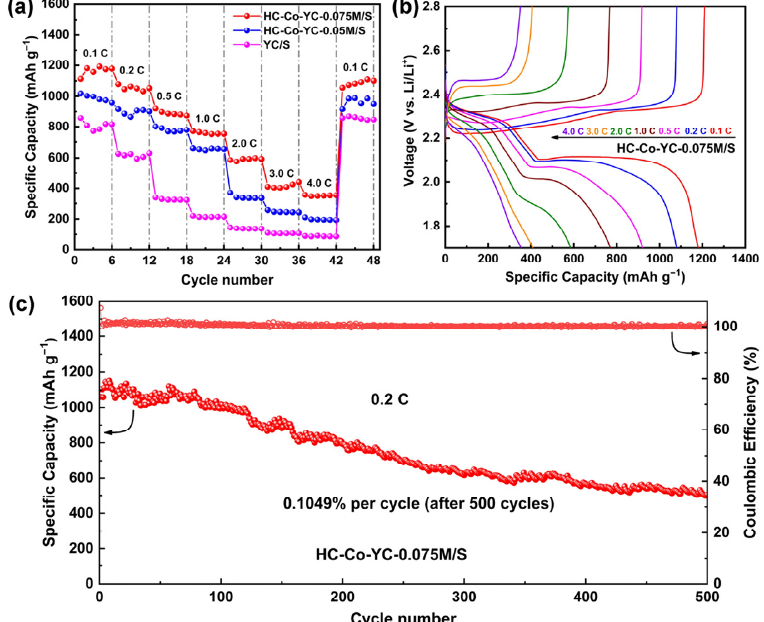
Figure 9. Electrochemical ( a ) rate capabilities of the HC–Co–YC–0.075M/S,